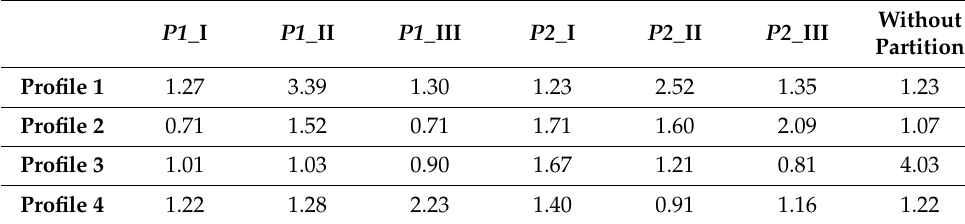
Table 5. Average stratification number ( Str